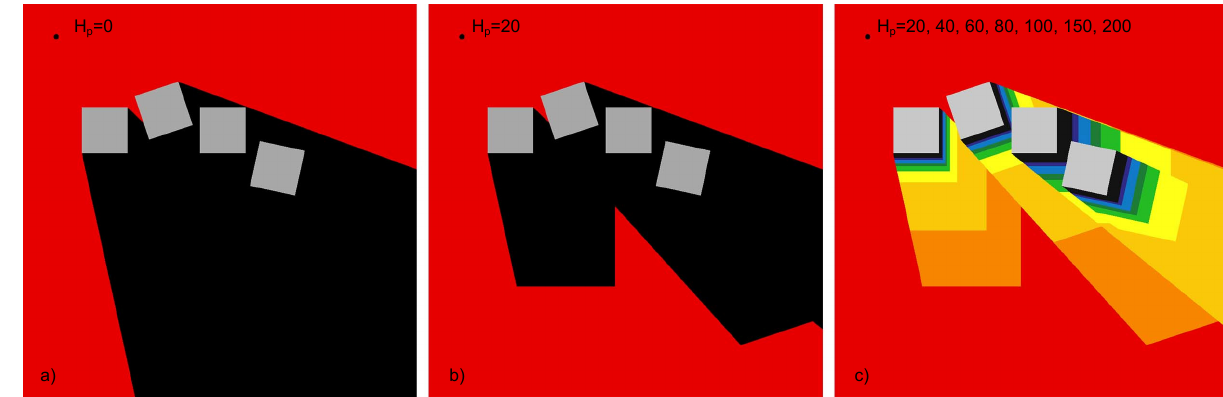
Figure 3. Differences between isovist 2d and 3d: a) plane 2d isovist, where visible area is marked with red; b) 3d isovist for measurement point at 20m above ground; c) Visual Impact Size method (VIS) for several thresholds